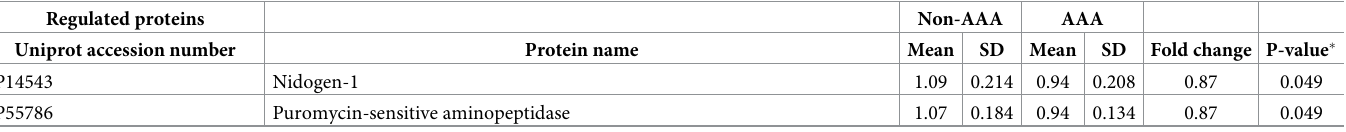
To verify some of the protein results, we performed an additional LC-MS/MS run on all samples using label-free quantification on remaining protein digests. We verified the presence of other peptides for proteins in the elastin-related-protein group. Although quantitation by this method in our samples is considerably more imprecise than the above used method with TMT-labelling, we were able to find results displaying comparable results, although some do not reach significance (elastin: 63+/-4.2 (AAA) vs 35+/-2.7 (non-AAA) (p = 0.01); MFAP4: